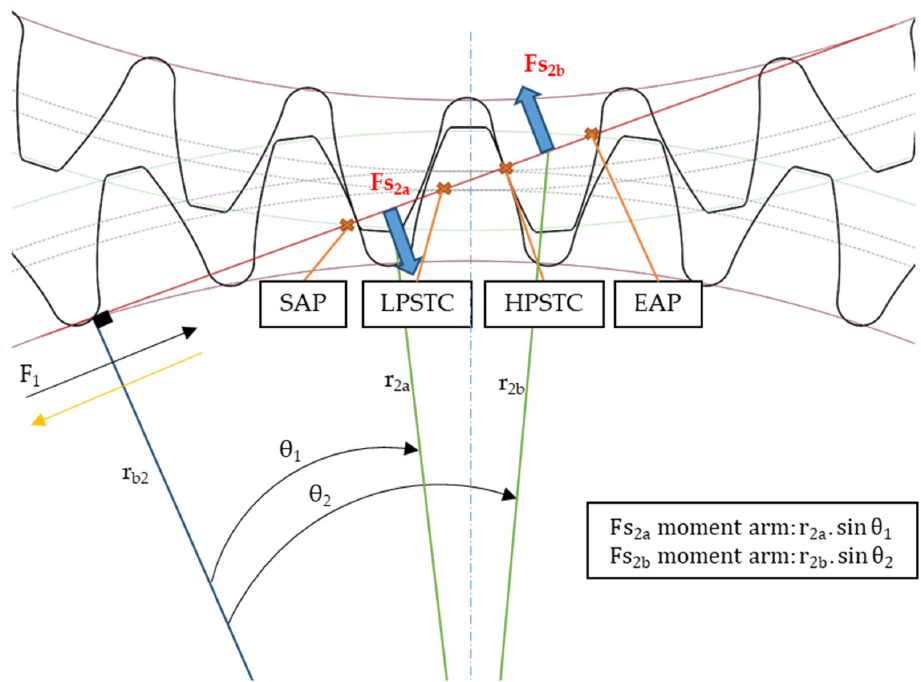
Figure 4. Determination of friction torque relative to the contact point.